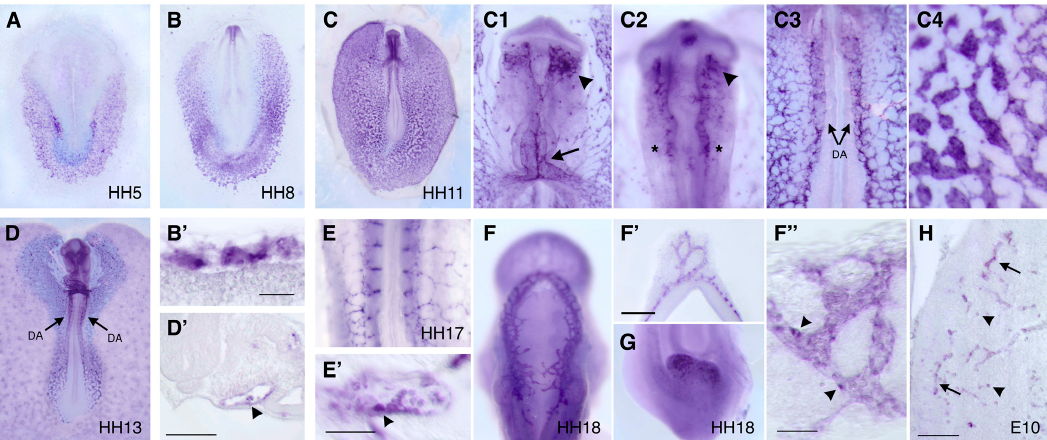
Figure 3. cDIA1R expression in the chick embryo. cDIA1R in situ hybridization was performed on whole-mount embryos at HH5 ( A ), 8 ( B ), 11 ( C ), 13 ( D ), 17 ( E ), 18 ( F , G ) and on a E10 brain cryosection ( H ). ( B’ , D’ , E’ , F’ , F” ) Sections of correspondent whole-mount embryos. ( C1 – C4 ) Regions of embryo in ( C ) at high magnification. cDIA1R expression starts to be detected at HH5 ( A ) in the extraembryonic mesoderm that will form the yolk sac blood islands at later stages ( B , B’ , C4 ). In HH11 embryos ( C ), cDIA1R is also expressed in the endocardium (arrow in C1 ), in the developing head vasculature (arrowheads in C1 and C2 ), in cells associated with the dorsal mid- and hindbrain (asterisks in C2 ) and in the dorsal aorta region (DA; C3 ). At later stages ( D – H ), cDIA1R expression is detected in most blood vessels of the embryo, such as the dorsal aorta (DA in D , D’ ), intersomitic vessels ( E ), head vasculature ( E’ , F , F’ , F” ) and allantois ( G ). Higher intensity is found in particular blood vessel cells that resemble hemogenic endothelial cells ( D’ , E’ , F” ; arrowheads). In the brain neuroepithelium ( H ), cDIA1R is detected both in the neurovasculature (arrows) and in isolated cells that may be microglial cells (arrowheads). Scale bars: 50 μ m in B’ , E’ , F” ; 100 μ m in D’ , F’ .